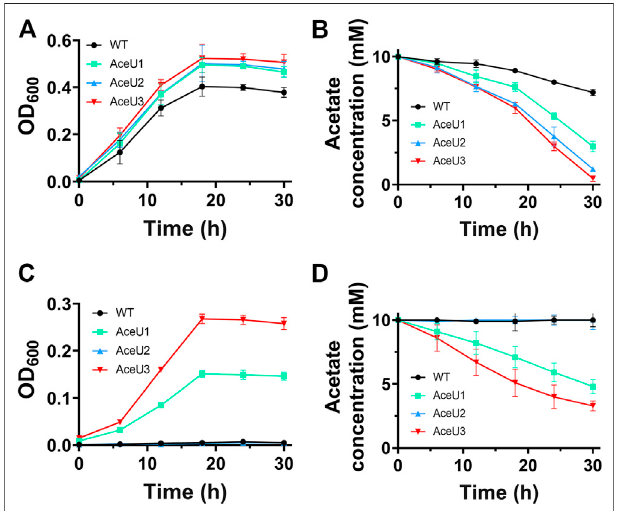
FIGURE 3 | Electrochemical analysis of the electrical production properties of WT and engineered S. oneidensis strains (AceU1, AceU2 and AceU3) with acetate as carbon sources. (A) MFCs discharge curve of four strains WT, AceU1, AceU2 and AceU3, using acetate as carbon source. 20 mM acetate was added at the initiation of MFC operations. (B) MFCs power density output curves obtainedbylinearsweepvoltammetry